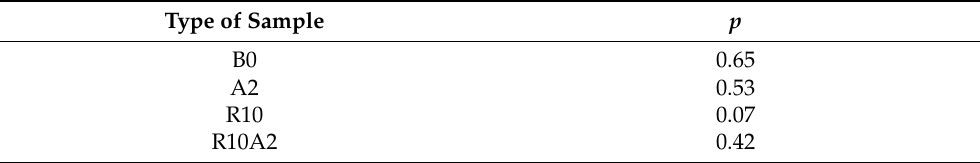
Table 3. The p -values of the Shapiro – Wilk distribution normality tests.